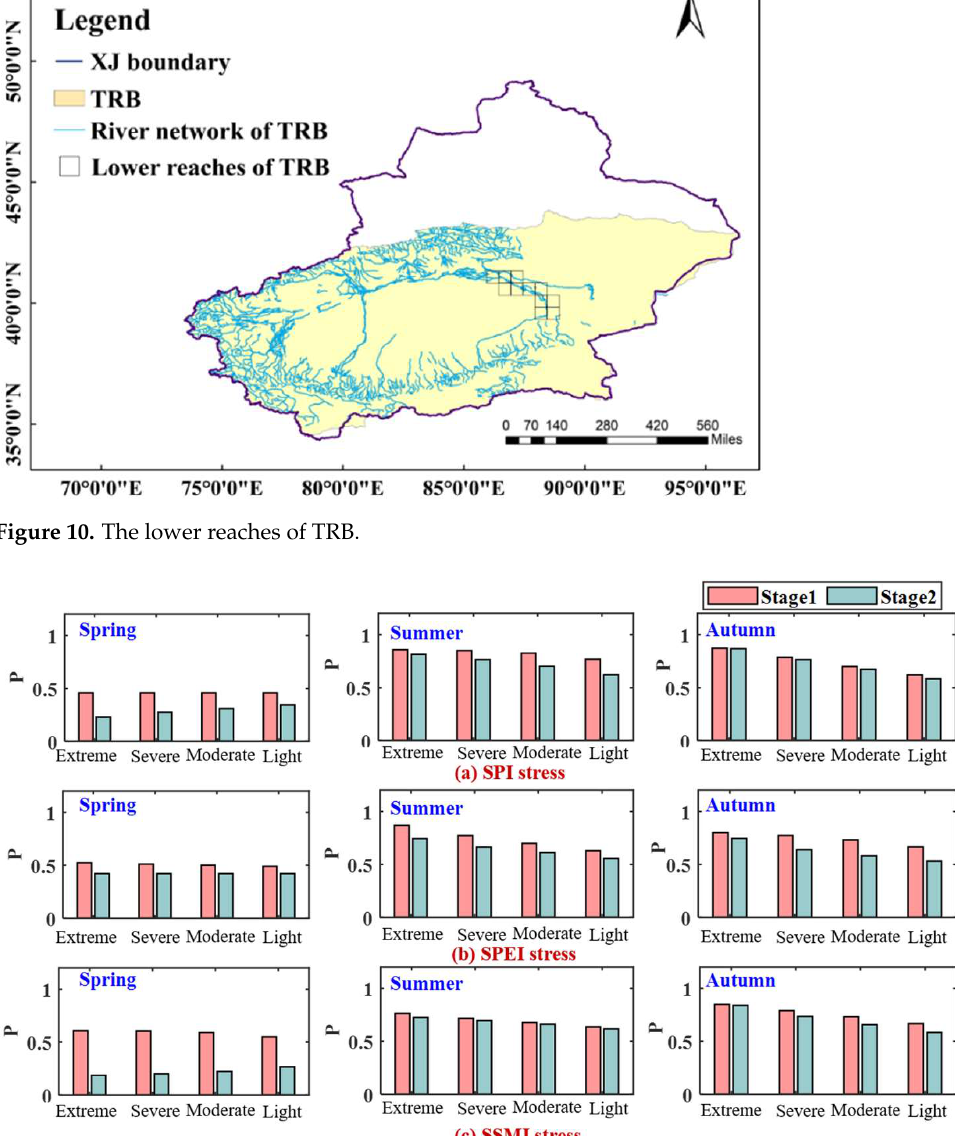
Figure 11. Comparison of conditional probability of NDVI vulnerability of the lower reaches of TRB between stage 2 and stage 1 under SPI stress ( a ), SPEI stress ( b ) and SSMI stress ( c ).